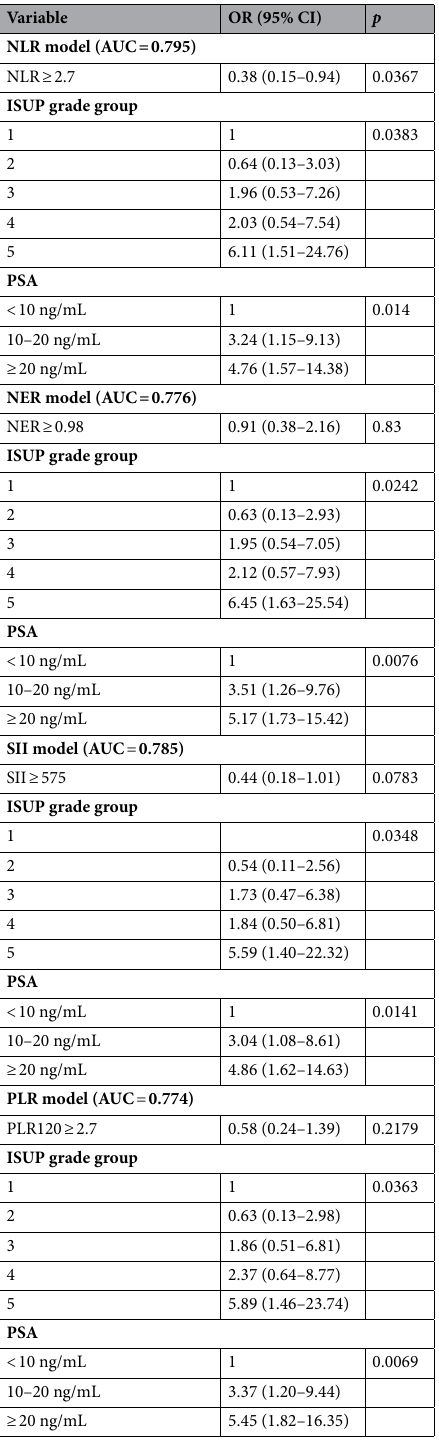
Table 2. The association of haematological markers and nodal involvement—multivariable logistic regression analysis. OR odds ratio, CI confidence interval, NLR neutrophil-to-lymphocyte ratio, PSA